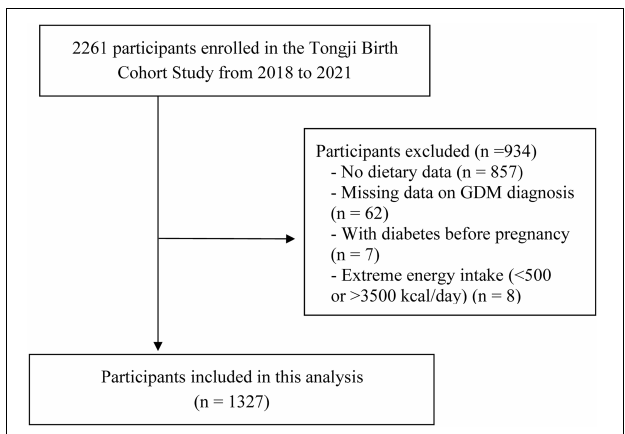
FIGURE 1 | Flow chart for the selection of subjects included in the